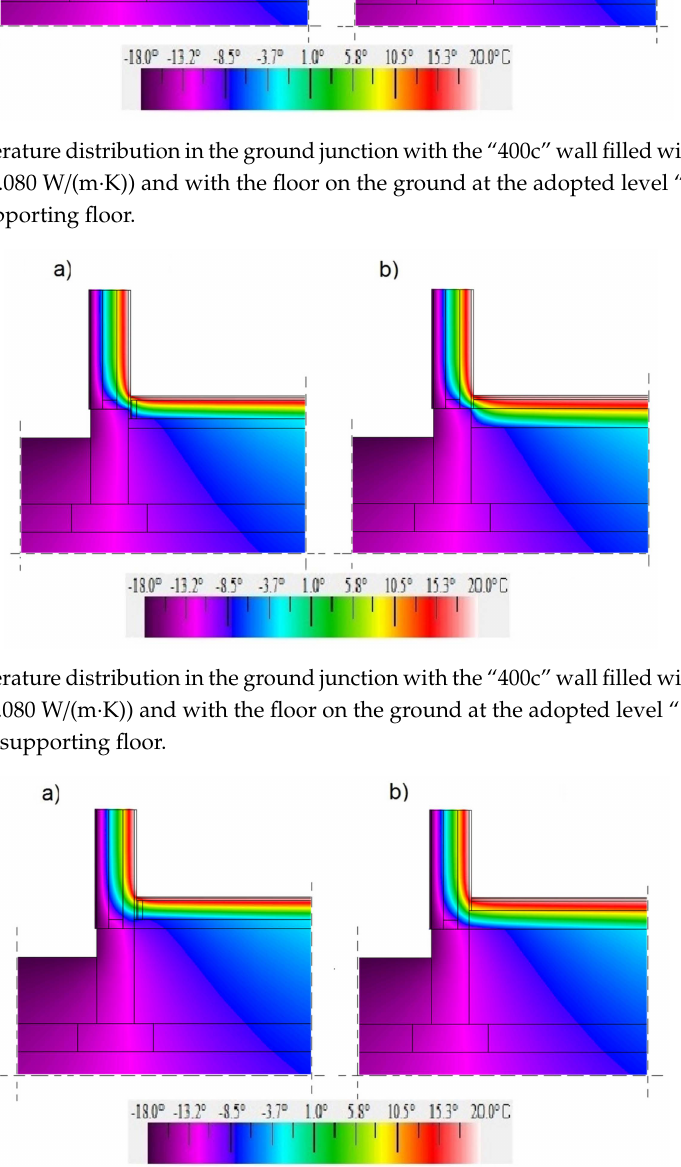
Figure 13. Temperature distribution in the ground junction with the “400c” wall filled with a hemp–lime composite ( λ = 0.080 W / (m · K)) and with the floor on the ground at the adopted level “ + 100”: ( a ) floor on joists; ( b ) self-supporting